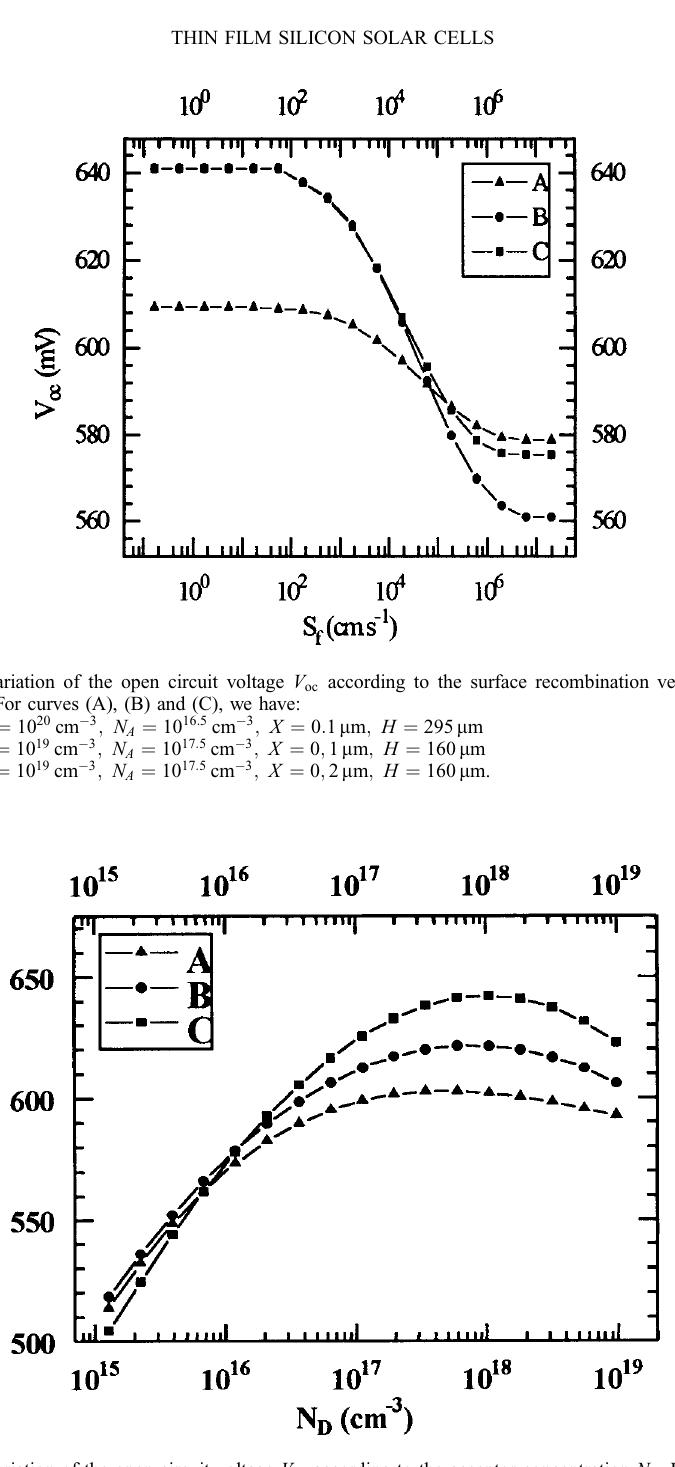
FIGURE 8 Variation of the open circuit voltage V oc according to the acceptor concentration N A . For curves (A), (B) and (C), we have: Curve (A): N A ¼ 10 16 cm (cid:2) 3 ; X ¼ 0 : 2 m m ; H ¼ 295 m m ; S b ¼ 10 15 cm (cid:3) s (cid:2) 1 ; S f ¼ 10 6 cm (cid:3) s (cid:2) 1 Curve (B): N A ¼ 10 16 cm (cid:2) 3 ; X ¼ 0 : 6 m m ; H ¼ 295 m m ; S b ¼ 10 15 cm (cid:3) s (cid:2) 1 ; S f ¼ 10 2 cm (cid:3) s (cid:2) 1 Curve (C): N A ¼ 10 15 : 5 cm (cid:2) 3 ; X ¼ 0 : 5 m m ; H ¼ 295 m m ; S b ¼ 10 15 cm (cid:3) s (cid:2) 1 ; S f ¼ 10 2 cm (cid:3) s (cid:2) 1